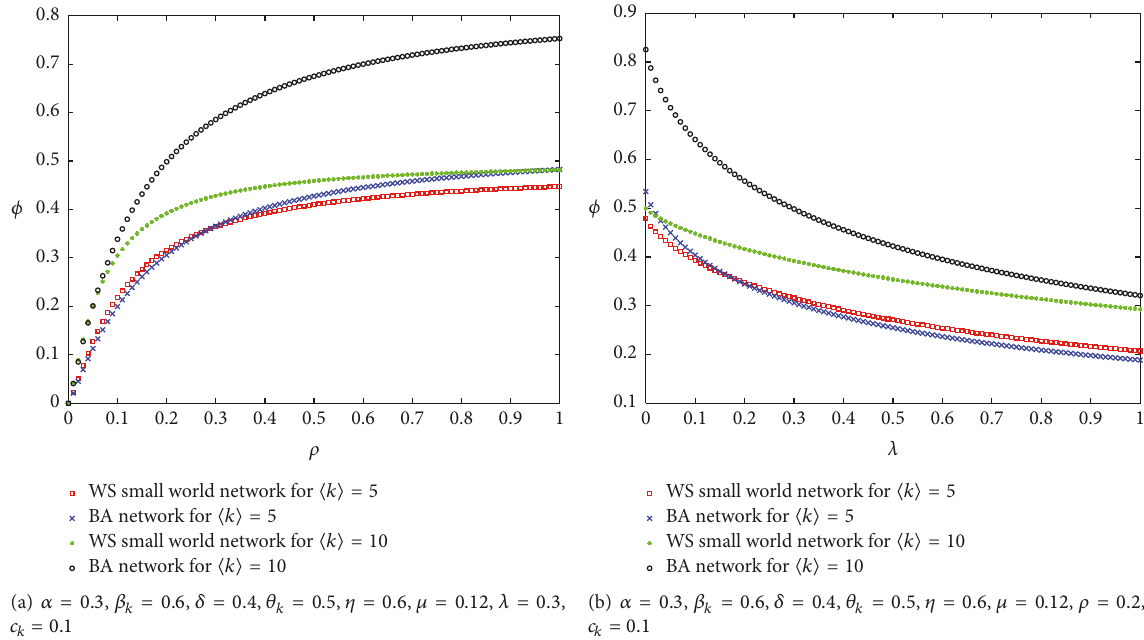
Figure 4: The evolution function of the contagious scale 𝜙 of credit risk as function in the malicious attack strength 𝜌 of some institutional investors and the official rescue strength 𝜆 under the different network structure. (a) for 𝛼 = 0.3 , 𝛽 𝑘 = 0.6 , 𝛿 = 0.4 , 𝜃 = 0.5 , 𝜂 = 0.6 , 𝜇 = 0.12 , 𝜆 = 0.3 , 𝑐 = 0.1 ; (b) for 𝛼 = 0.3 , 𝛽 = 0.6 , 𝛿 = 0.4 , 𝜃 = 0.5 , 𝜂 = 0.6 , 𝜇 = 0.12 , 𝜌 = 0.2 , 𝑐 𝑘 𝑘